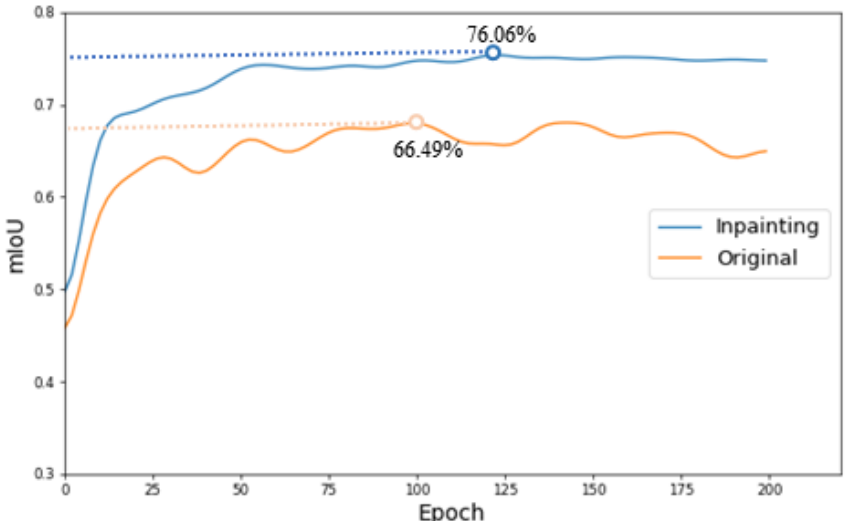
Figure 9. The accuracy graph of lesion segmentation of the Unet [19] model. The blue line represents the accuracy of using the inpainting images as the training set. The yellow line represents the accuracy of using the original images with symbols as the training